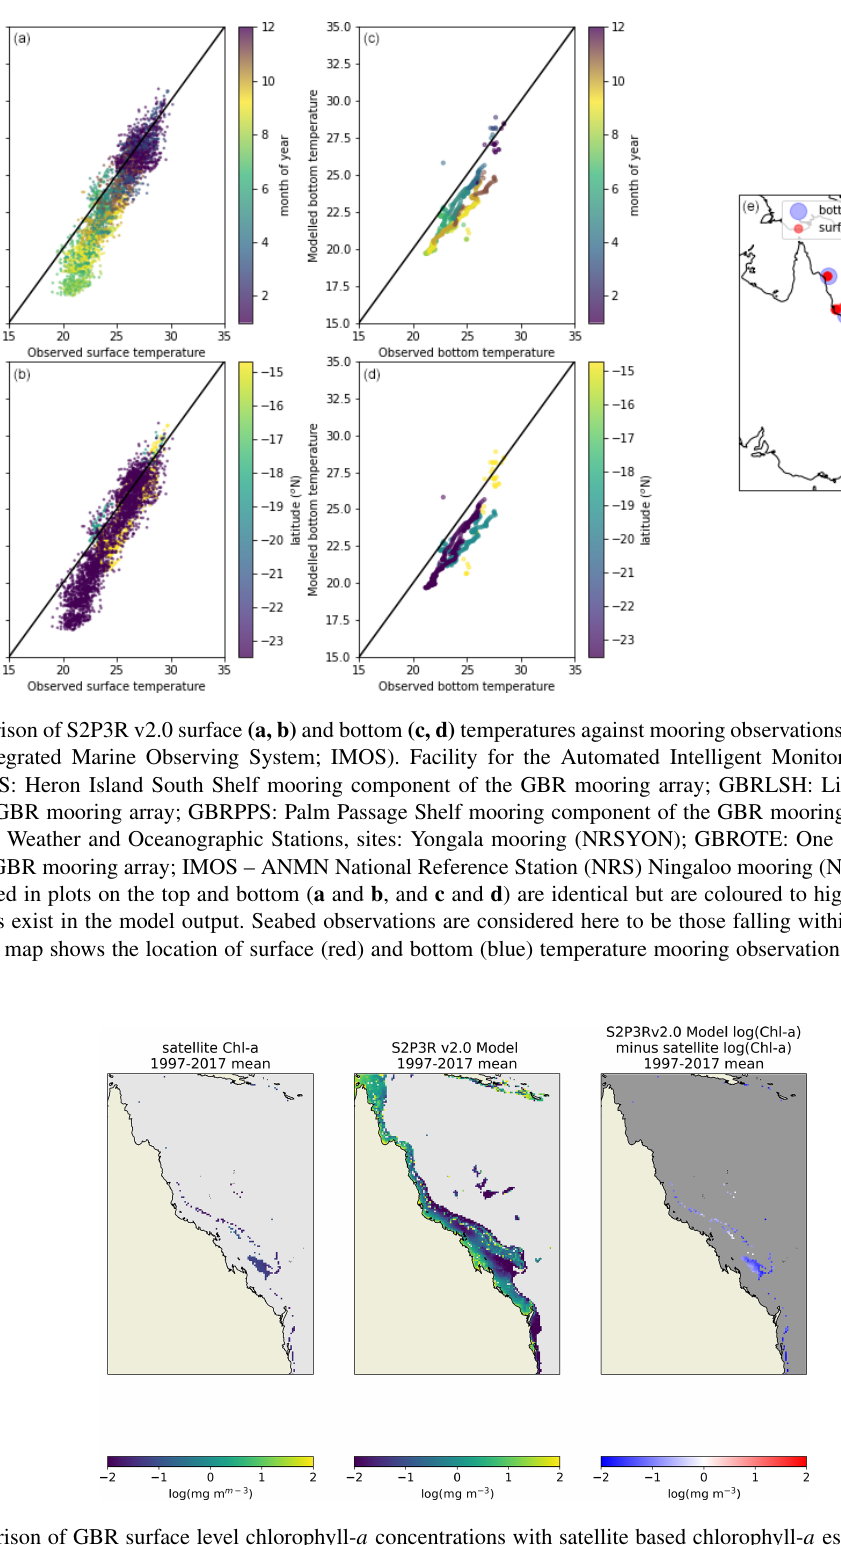
Figure 18. Comparison of GBR surface level chlorophyll- a concentrations with satellite based chlorophyll- a estimates (Sathyendranath et al., 2020). Figures present an annual mean of all data available between 1997 and 2017 inclusive. Satellite data are filtered to include just water ≥ 70m to minimise contamination by case-2